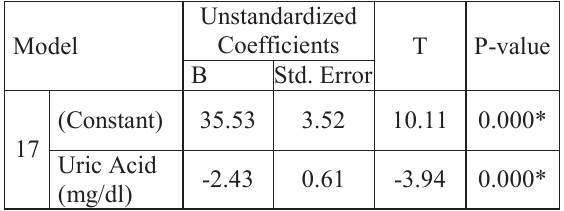
Table-2: Multiple linear regression analysis for studying relation of vitamin D with uric acid by using Backward method in both groups combined (R2 = 0.166 Adj R2=